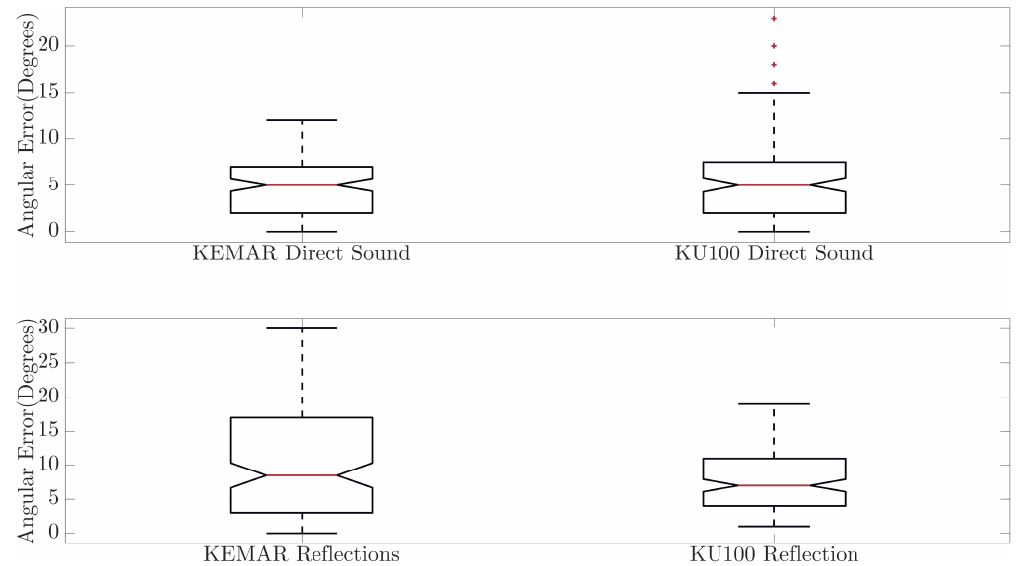
Figure 8. Boxplot comparison of angular errors in the neural network direction of arrival predictions between the KEMAR and KU100 dummy heads for direct sound ( top ) and reflected ( bottom )